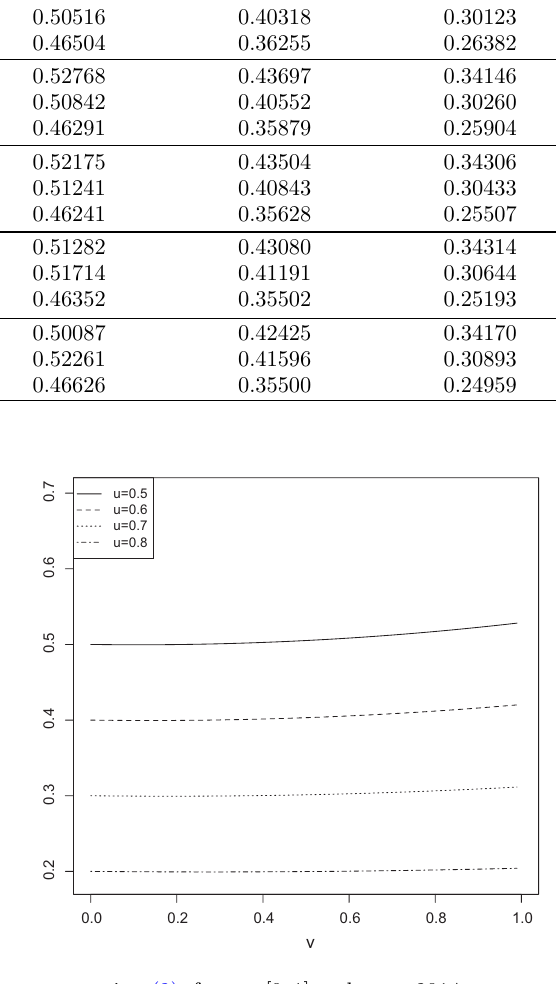
Figure 6. ^ P ð U > u j V > v Þ according to equation (2), for v 2 ½ 0 ; 1 (cid:3) and year: